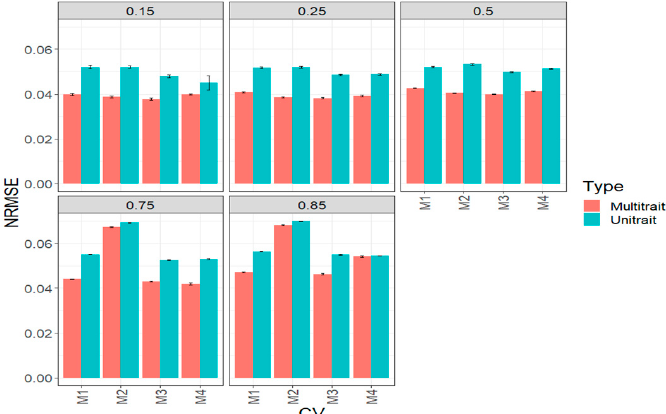
Figure 3. Prediction performance for the complete (big) maize data set in terms of normalized root mean square error (NRMSE) of the four methods of sparse testing (M1, M2, M3 and M4) under unit- trait and multi-trait models for 5 percentages of testing: 15% (0.1), 25% (0.25), 50% (0.5), 75% (0.75) and 85% (0.85).